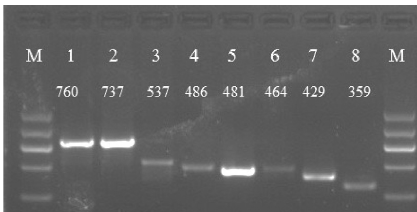
Figure 1: PCR amplification results for eight animal species. Lanes 1–8 represent goat, sheep, deer, buffalo, cattle, yak, pig, and camel, respectively. Lane M represents DNA marker; the lengths of dif- ferent PCR products were noted above the band.